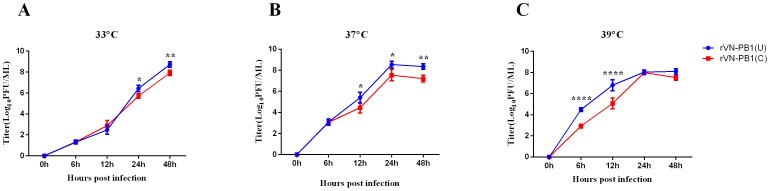
Growth kinetics of viruses with U4 and C4.(A), (B), and (C) The titers of rVN-PB1(U) and rVN-PB1(C) after infection and at different temperatures. The mean relative activity and standard deviation (error bar) were calculated from the results of three independent experiments. The data were analyzed with two-way ANOVA using GraphPad Prism Software, and the P values were calculated. (*) P<0.05; (**) P<0.01; (***) P<0.001; (****) P<0.0001.